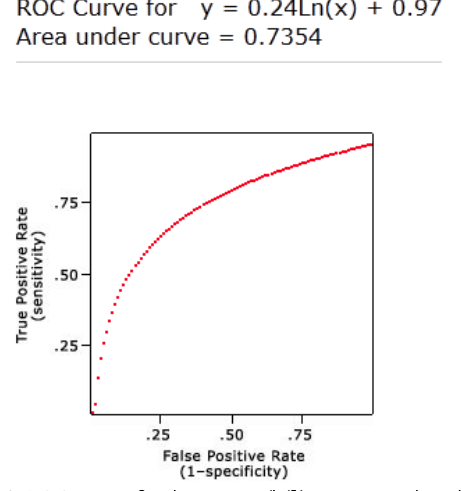
Figure 6. ROC curve for the susceptibility maps produced in this study Result of this final landslide susceptibility map is shown in the Fig 7